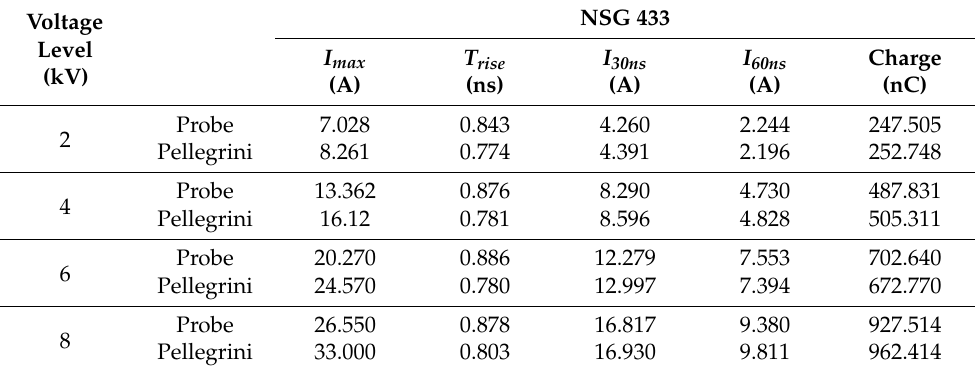
Table 4. Reconstructed and reference ESD current parameters for the Schaffner NSG 433